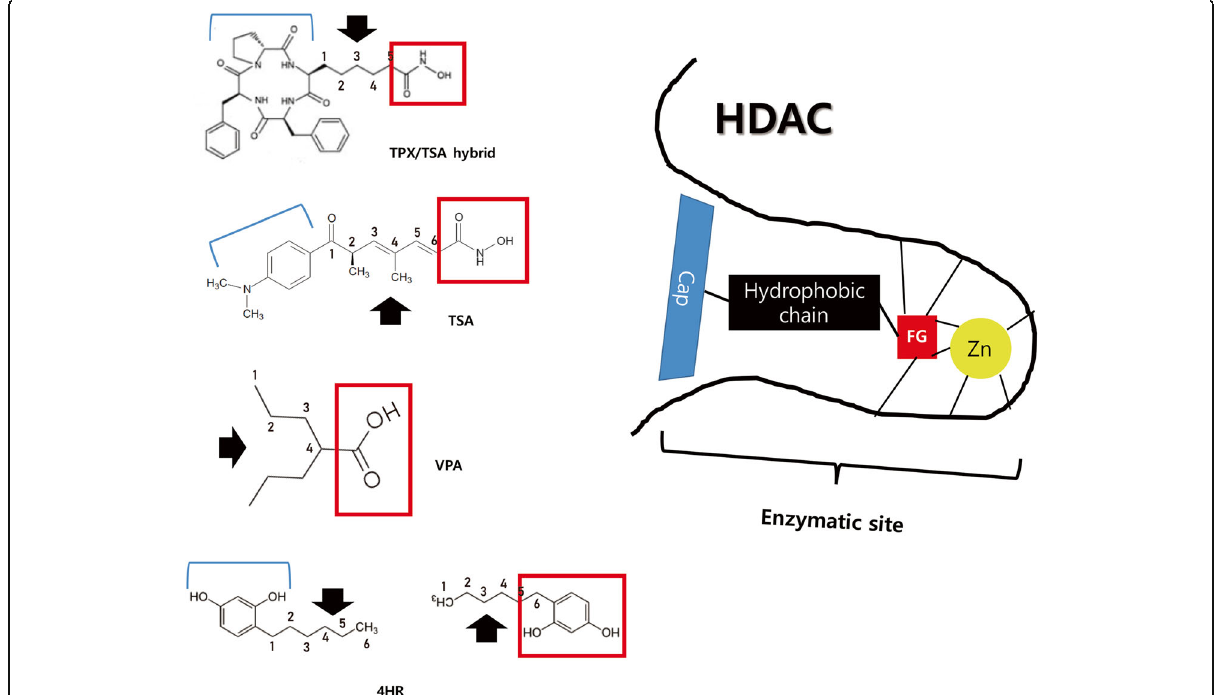
Fig. 3 Structures of known histone deacetylase (HDAC) inhibitor and 4-hexylresorcinol (4HR). Most HDAC inhibitors have 4 – 6 carbon length alkyl group. This alkyl group is a hydrophobic chain and corresponds to hydrophobic domain of HDAC. As zinc ion is required for HDAC activation, some HDAC inhibitors have functional group (FG). To block any introduction of substrate into HDAC enzymatic site cap domain (Cap) can be found in some HDAC inhibitor. Interestingly, hydroxyl-benzene in 4HR can be behaved like FG or Cap (modified from author ’ s own work